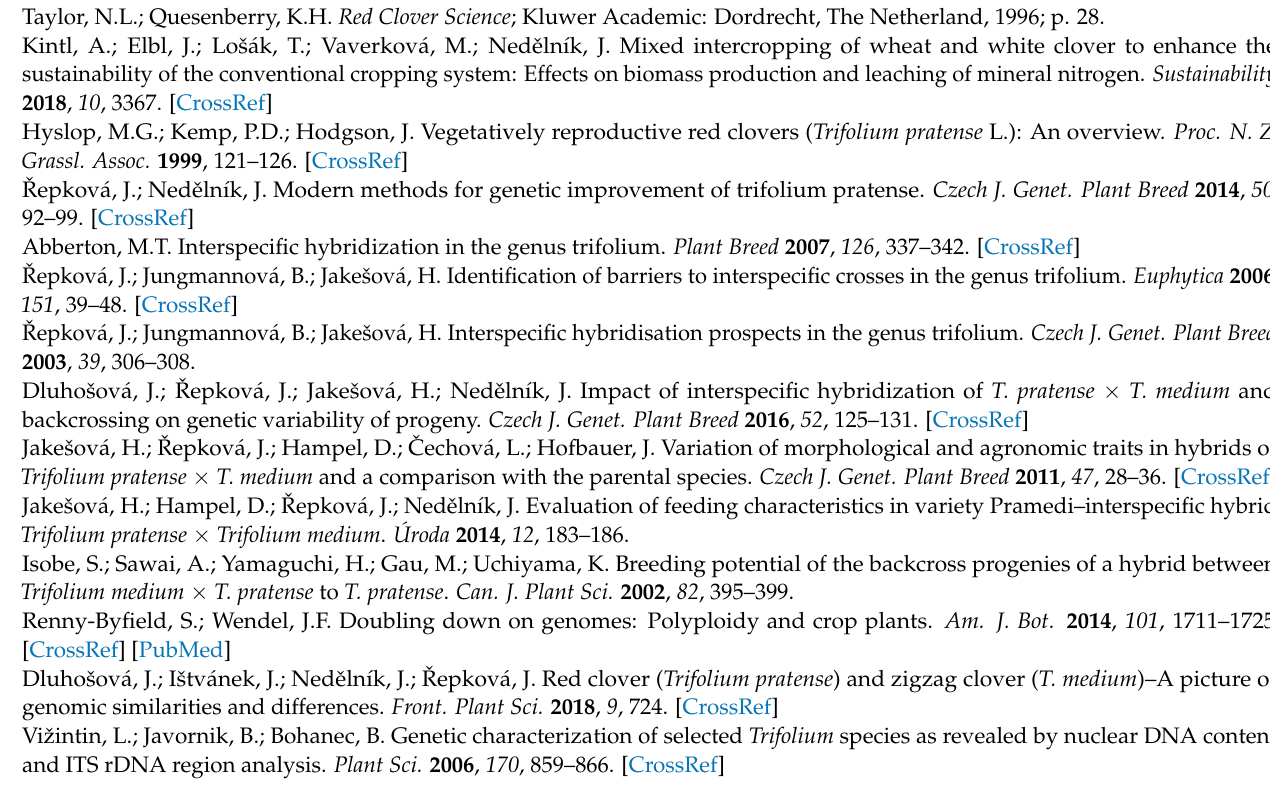
rDNA; Figure S2: T. medium ecotypes and varieties TrM300 and TrM378 repeats; Table S1: RepeatEx- plorer cluster annotation report 5S